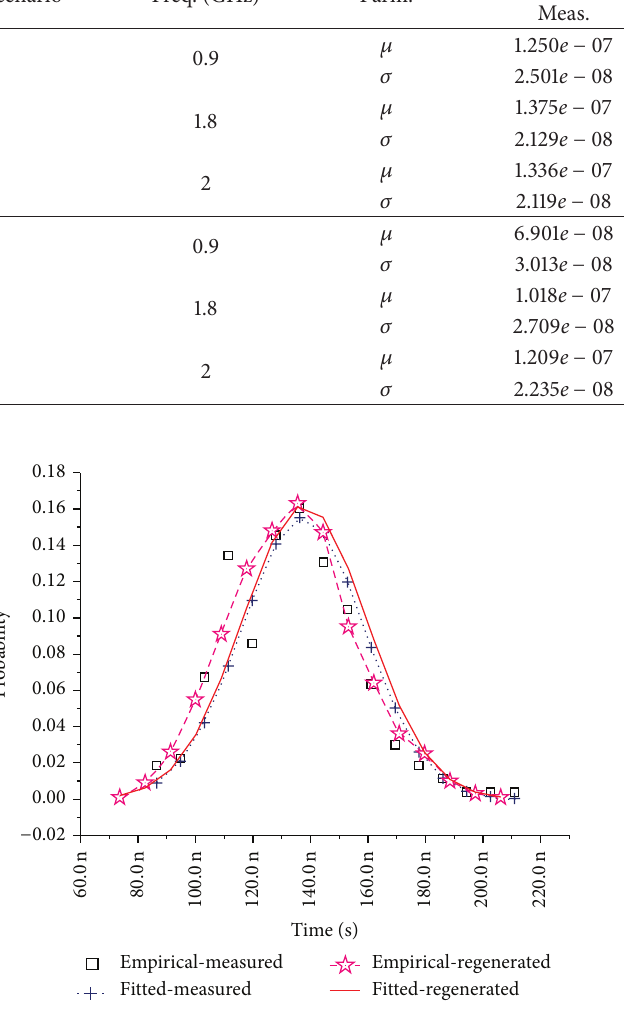
Figure 7: Comparison of the empirical distribution and fitted normal distribution of excess delay at 1.8 GHz in Scenario 1. “Measured” means that the data were obtained by experiments whereas “regenerated” means that they were obtained by channel simulator.